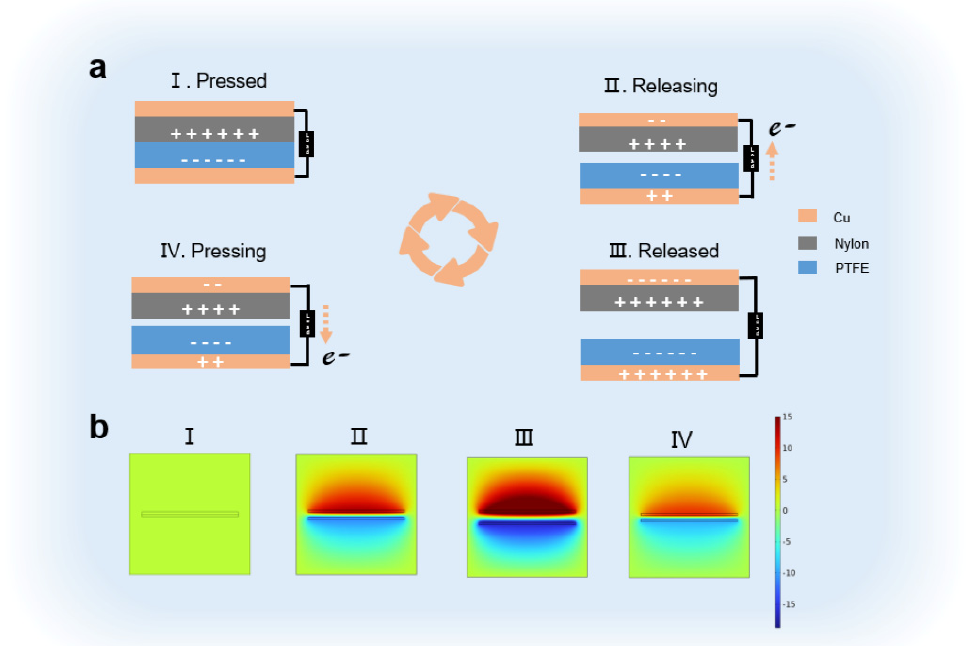
Figure 2. The LPS-TENG working mechanism and COMSOL potential distribution simulation. ( a ) Schematic diagram of the working mechanism of the LPS-TENG. ( b ) COMSOL simulation of the potential distribution of the LPS-TENG.